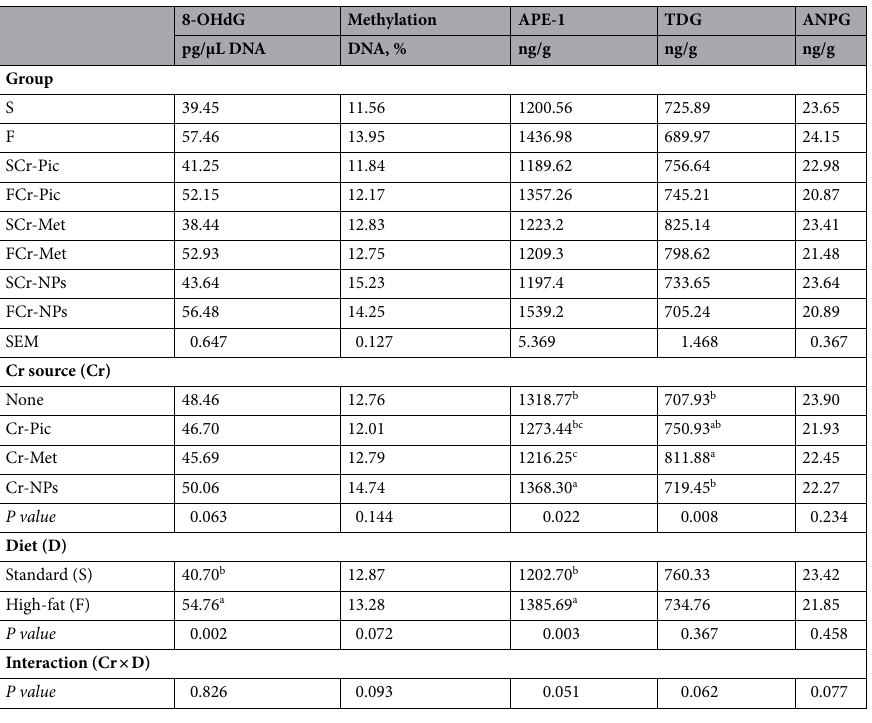
Table 3. Oxidative and epigenetic DNA damage and activity of repair enzymes in ileal tissues of rats fed experimental diets. S—rats fed a standard diet; F—rats fed a high-fat, low-fibre diet; SCr-Pic—rats fed diet S supplemented with 0.3 mg Cr/kg BW from chromium(III) picolinate; FCr-Pic—rats fed diet F supplemented with 0.3 mg Cr/kg BW from chromium(III) picolinate; SCr-Met—rats fed diet S supplemented with 0.3 mg Cr/kg BW from chromium(III)-methionine; FCr-Met—rats fed diet F supplemented with 0.3 mg Cr/kg BW from chromium(III)-methionine; SCr-NPs—rats fed diet S supplemented with 0.3 mg Cr/kg BW from nano-sized chromium; FCr-NPs—rats fed diet F supplemented with 0.3 mg Cr/kg BW from nano-sized chromium. a,b,c Means within a column with different superscript letters are significantly different ( P < 0.05); differences between groups (S, F, SCr-Pic, FCr-Pic, SCr-Met, FCr-Met, SCr-NPs and FCr-NPs) are indicated with superscripts only in the case of a statistically significant interaction Cr × D ( p < 0.05). SEM—pooled standard error of mean (standard deviation for all rats divided by the square root of the number of rats, n = 56). 8-OHdG—8-hydroxydeoxyguanosine; APE-1—apurinic/apyrimidinic endonuclease 1; TDG—thymine DNA glycosylase; ANPG—DNA-3-methyladenine